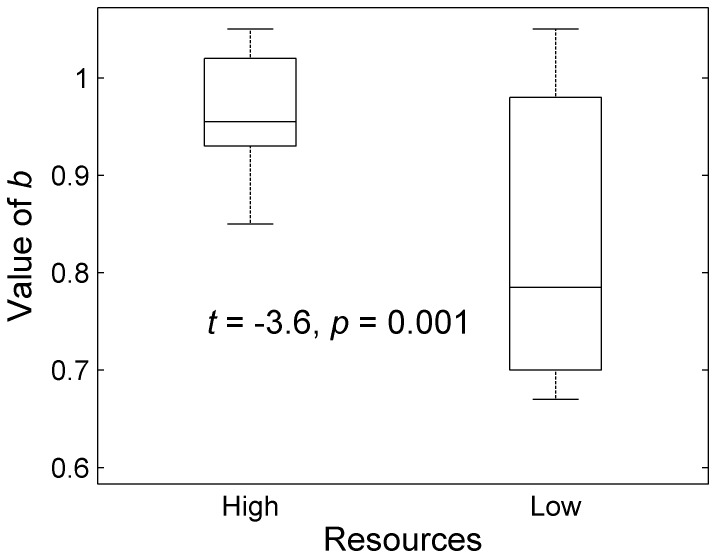
Box plot of the values of the metabolic scaling slope b from studies that provided high and low levels of resources.Boxes show median and 25th and 75th percentiles. See Table S1 for details for each study [38], [50]–[58].